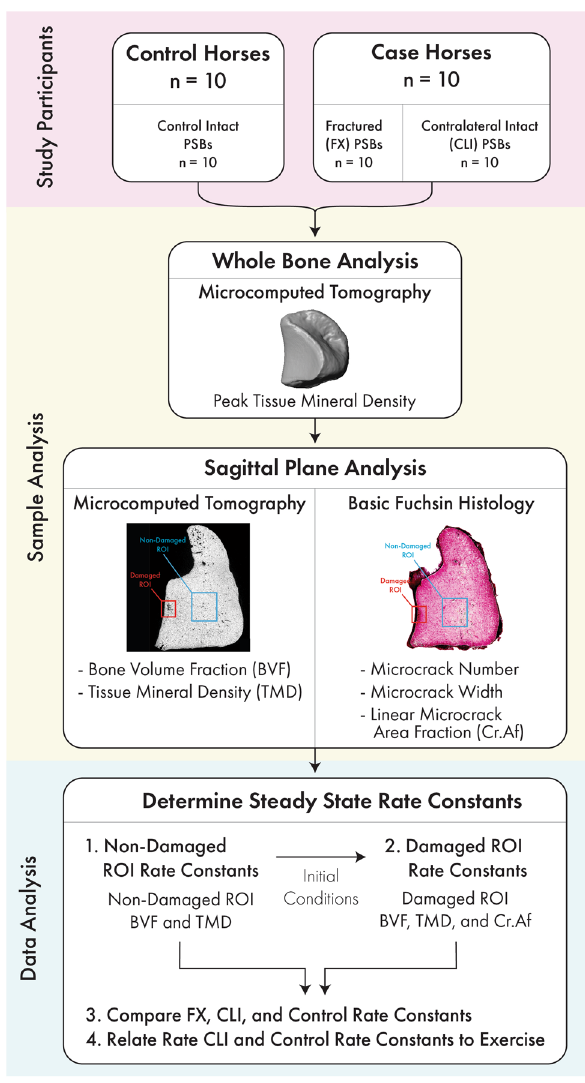
Figure 2. Flowchart of study methods. Study participants: Data were collected from 30 racehorse proximal sesamoid bones (PSBs). Specifically, data were measured within ten fractured medial PSBs (FX-PSB) from Case racehorses euthanized due to unilateral biaxial PSB fracture, ten contralateral limb intact medial PSBs (CLI- PSBs) from the same Case racehorses, and ten medial PSBs from Control racehorses (CTRL-PSBs) euthanized for reasons unrelated to PSB fracture 17 . All horses were in race-training at the time of death 25 . Sample analysis: The whole PSB was used to determine the peak tissue mineral density of the sample. Data was collected in two sagittal plane regions of interest (ROIs): A Non-Damaged ROI (blue) and Damaged ROI (red). These regions are described in detail in Shaffer et al., 2022 25 . Data analysis: Steady-state rate constants were first determined in the Non-Damaged ROI (1). Second, steady-state rate constants were determined within the Damaged ROI (2), using the rate constants for the Non-Damaged ROI (1) as initial conditions. Finally, the rate constants were compared among groups (3). CLI-PSB and Control PSB rate constants were related to exercise variables (4). Note that FX rate constants were excluded from this final analysis (4) because Case FX and Case CLI PSBs are from the same horses and, therefore, have the same exercise